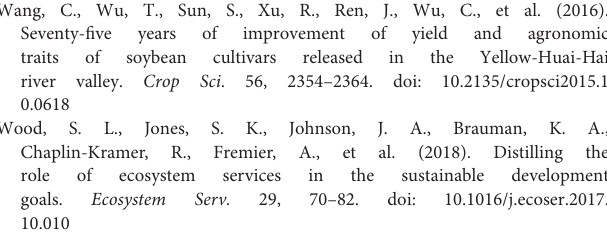
river valley. Crop Sci . 56, 2354–2364. doi: